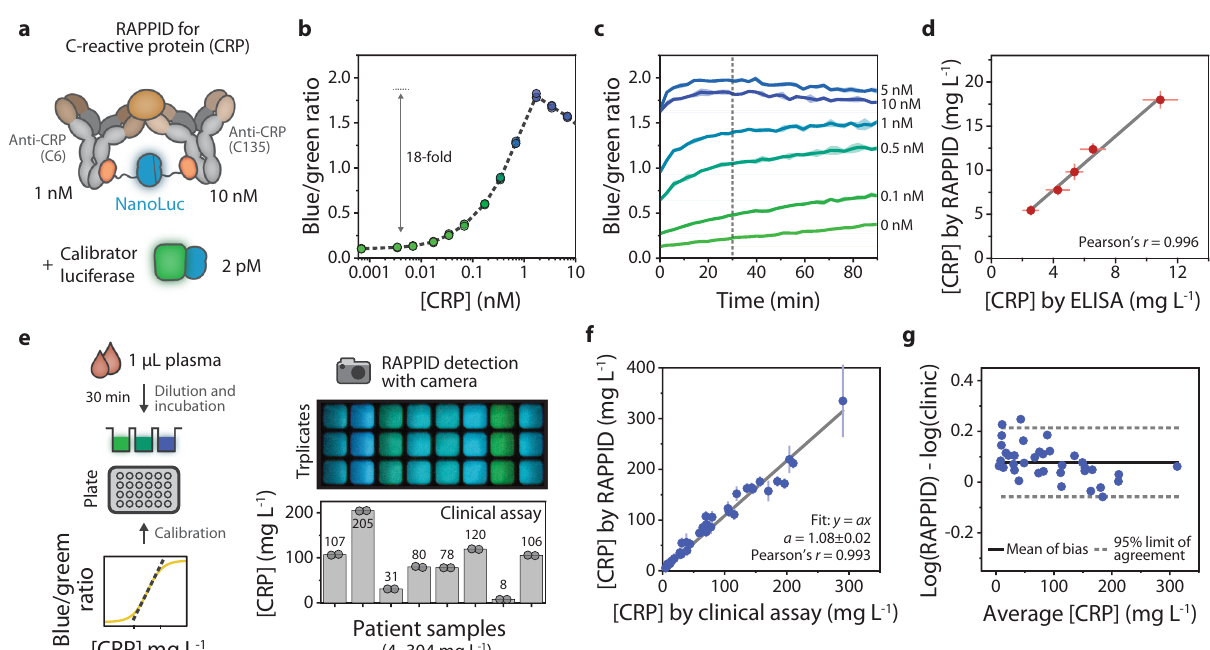
Fig. 3 Development and clinical validation of a RAPPID sensor for the detection of C-reactive protein (CRP). a Schematic illustration of the sensor components used for the detection of CRP. All RAPPID assays were performed in technical triplicate with independent preparations of the analyte, with 1 nM anti-CRP (C6) conjugated to Gx-LB, 10nM anti-CRP (C135) conjugated to Gx-SB. Reaction mixtures were prepared in buffer (PBS (pH 7.4), 0.1% (w/v) BSA) and incubated for 30 min at room temperature prior to addition of NanoLuc substrate and recording of the emission spectra unless indicated otherwise. The blue/green ratio was calculated by dividing emission at 458nm by emission at 518 nm. b Sensor response curve for increasing concentrations of CRP, displaying an 18-fold maximal increase in signal. Data points represent technical replicates, with n = 3 independent preparations of the analyte. c Sensor output over time at various concentrations of CRP, as indicated in the graph. All components (sensor, calibrator, analyte, substrate) were added simultaneously at t = 0. The dashed line indicates the 30-min. incubation time used in all other assays in this fi gure. Data are represented as mean ± sd of technical triplicates, with n = 3 independent preparations of the analyte. d Correlation of CRP concentrations measured by ELISA and RAPPID. Samples were prepared in diluted blood plasma and quanti fi ed using calibration curves obtained in buffer (see Supplementary Fig. 19). Error bars represent mean ±sd (technical replicates, with n = 4 independent preparations of the analyte). The solid line indicates linear fi t. Regression analysis yielded a Pearson ’ s correlation coef fi cient ( r ) = 0.996. e Clinical validation was performed against an agglutination-based clinical CRP assay with a detection range of 4 – 304 mg/L (0.03 – 2.4 µ M). For RAPPID assays, samples were diluted 1000-fold or 4000-fold in a buffer prior to incubation, and detection was performed using a digital camera (for full method details, see Supplementary Fig. 20). The photograph shows the sensor output for eight patient plasma samples measured in triplicate, with corresponding CRP concentrations as determined by the clinical assay in the histogram below. Bars and numbers represent mean values. f Quanti fi cation of CRP levels in patient plasma, total n = 40. The graph shows CRP concentrations as determined by the RAPPID assay plotted against results from the clinical assay. Values for the clinical assay represent the average of n = 2 independent measurements. For RAPPID, values represent the mean ±sd of technical replicates from n = 3, wherein the patient samples were independently prepared. The solid line indicates a linear fi t, with a slope of 1.08 ± 0.02 and Pearson ’ s r 0.993. Four samples yielded concentrations below the lower assay limit (<4mg/L) in both the clinical assay and RAPPID assay, these were omitted in the statistical analysis. The underlying data are listed in Supplementary Table 3. g Bland – Altman analysis for the data described in ( f ). The solid line represents the mean of bias between RAPPID and the clinical assay, dashed lines indicate the 95% limit of agreement (mean ±1.96× sd). Source data are provided as a Source Data fi